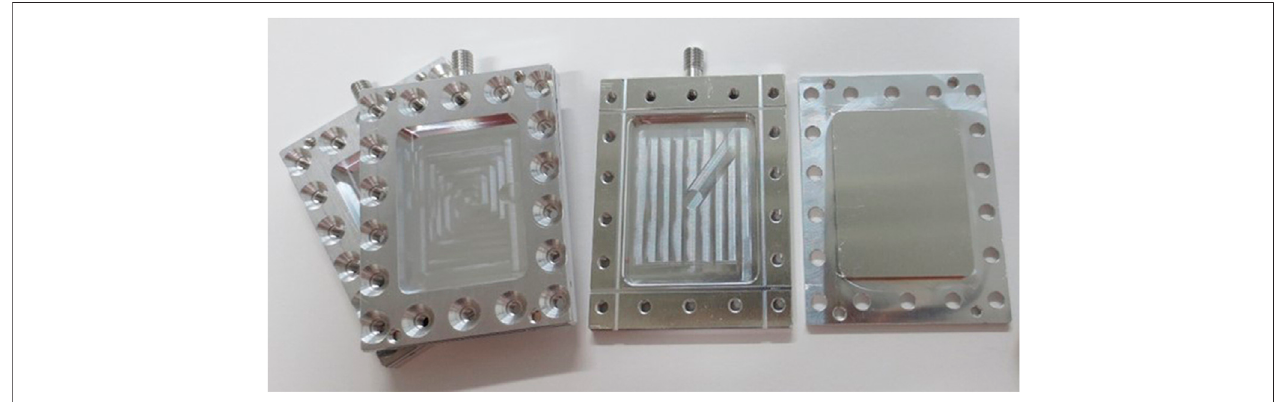
FIGURE 1 | Photographic image of the fl at aluminum cell used in this study. The PMMA sheet wrapped in Nb foil was installed in the center of the sample space (30 mm × 40 mm) and sealed by an indium wire to prevent the evaporation of water during measurement.